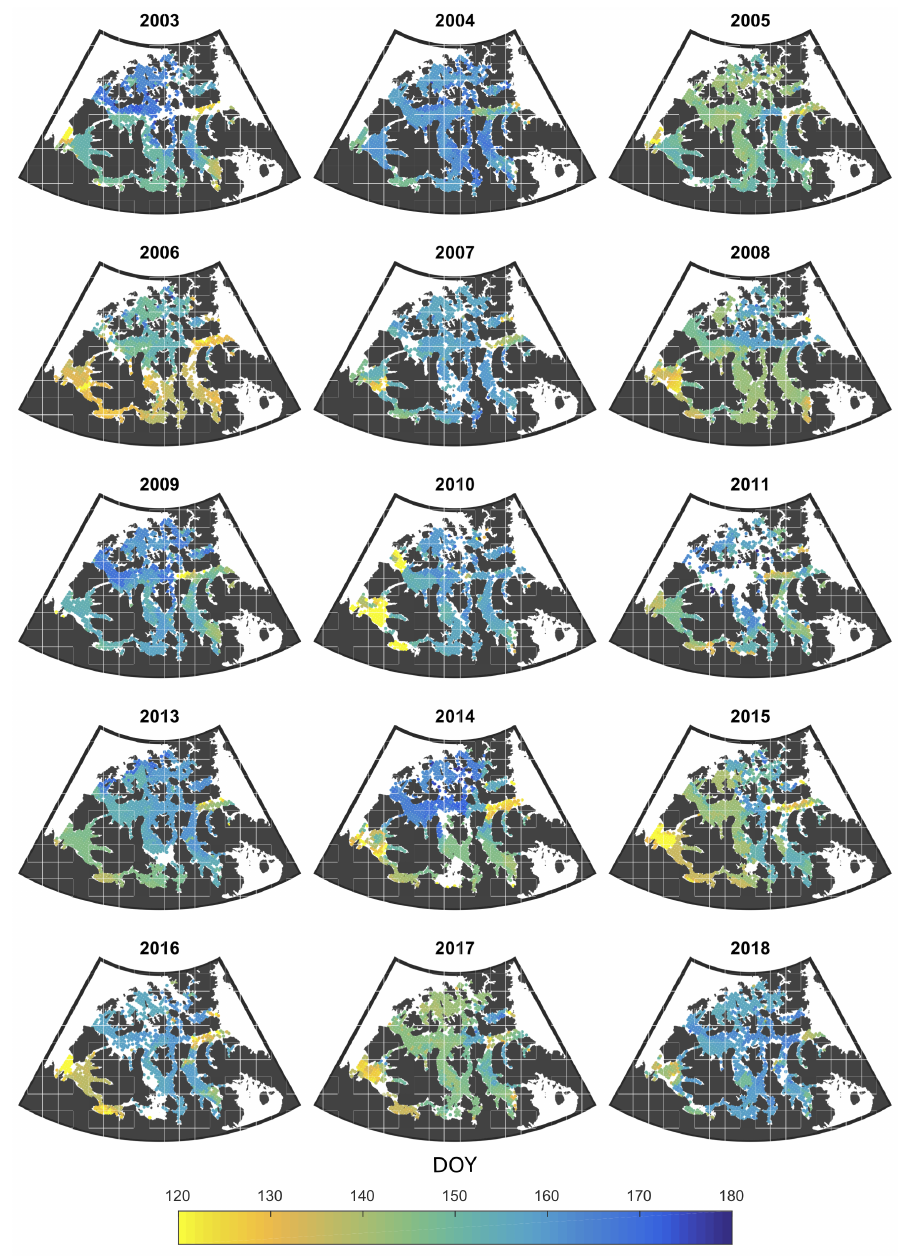
Figure 10. DTVM MO dates for the CAA from 2003 to 2018 at 25 km